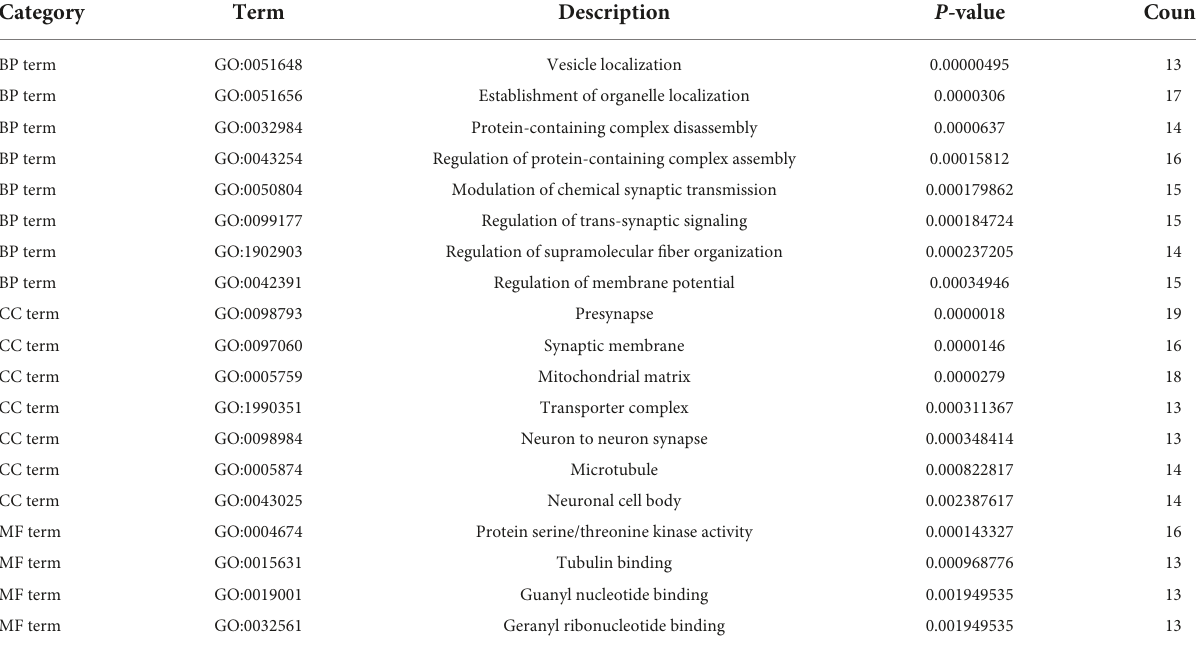
TABLE 1 Significantly enriched gene ontology (GO) terms of differentially expressed genes